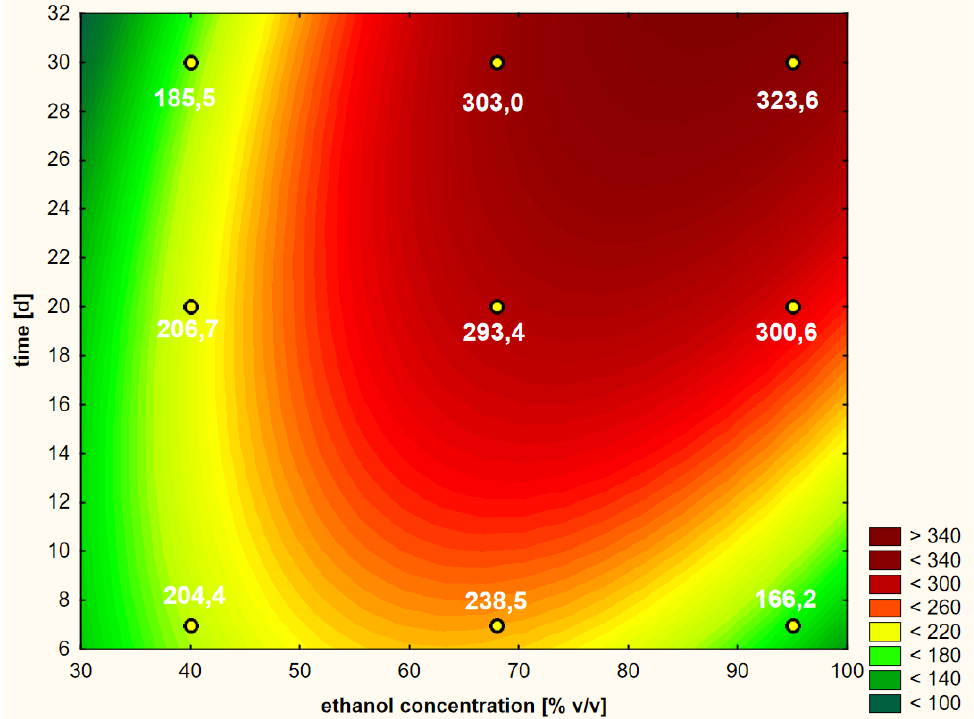
Figure 8. Model of the response surface regarding the contents of chlorogenic acid in ethanol extracts of elderberry flowers obtained from previously frozen raw material that was initially treated with warm ethanol at 50 °C.